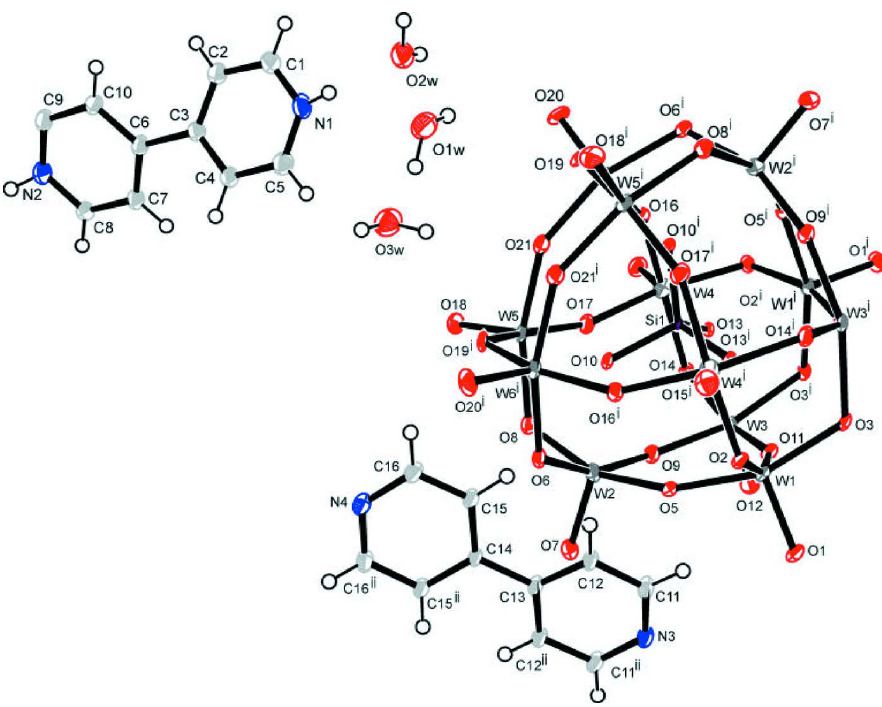
Figure 1 A view of the structure of the title compound. Displacement ellipsoids are drawn at the 50% probability level. H atoms are presented as a small spheres of arbitraryv radius. Symmetry codes: i = - x +2, y , - z +3/2; ii = - x +1, y , - z +3/2. Bis(4,4 ′ -bipyridinium) dodecatungstosilicate 4,4 ′ -bipyridine